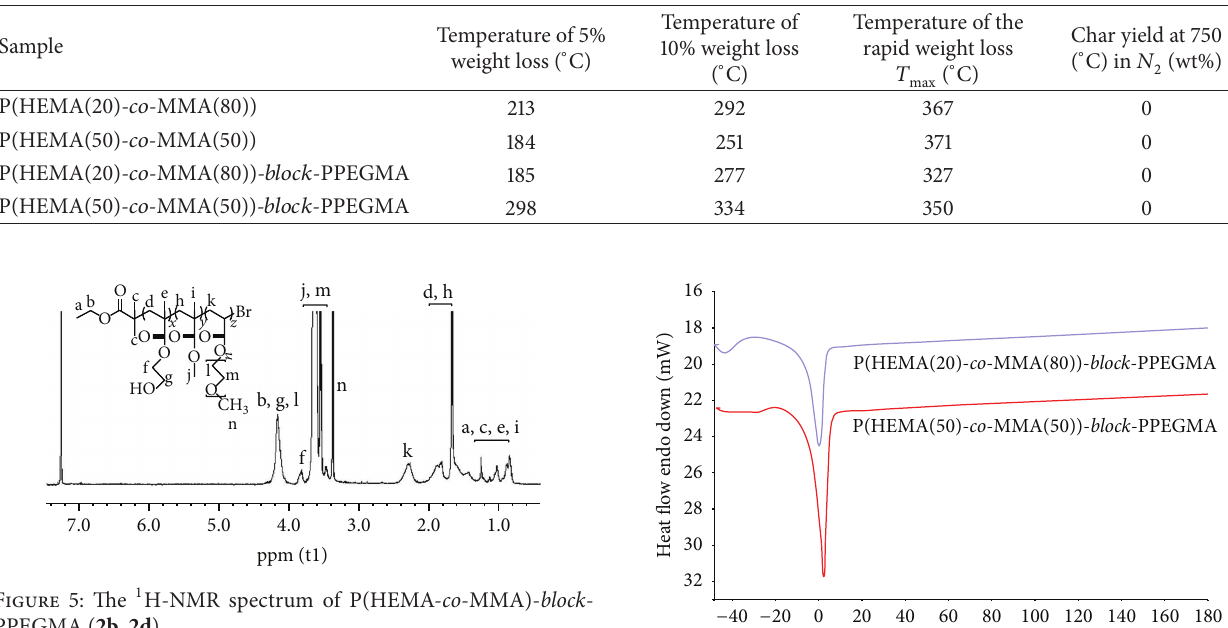
Table 4: Temperatures of various decompositions and char yield in N 2 at 750 ∘ C.